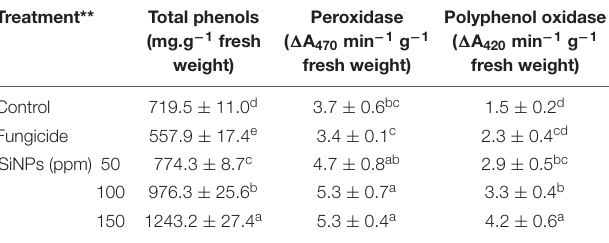
TABLE 6 | Effects of foliar application of SiNPs on the total phenolic content and activities of peroxidase and polyphenol oxidase enzymes in the leaves of grapevines infected with downy mildew at 15 days post the second